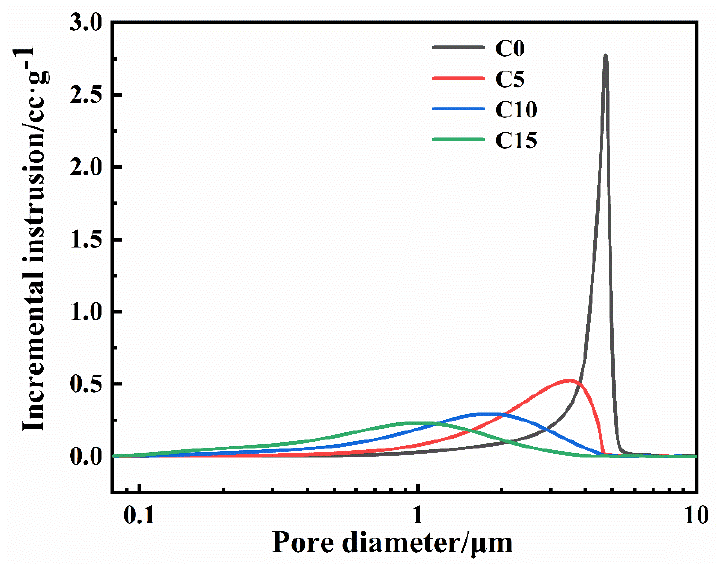
Figure 8. Pore size distribution of the green body with different carbon contents.